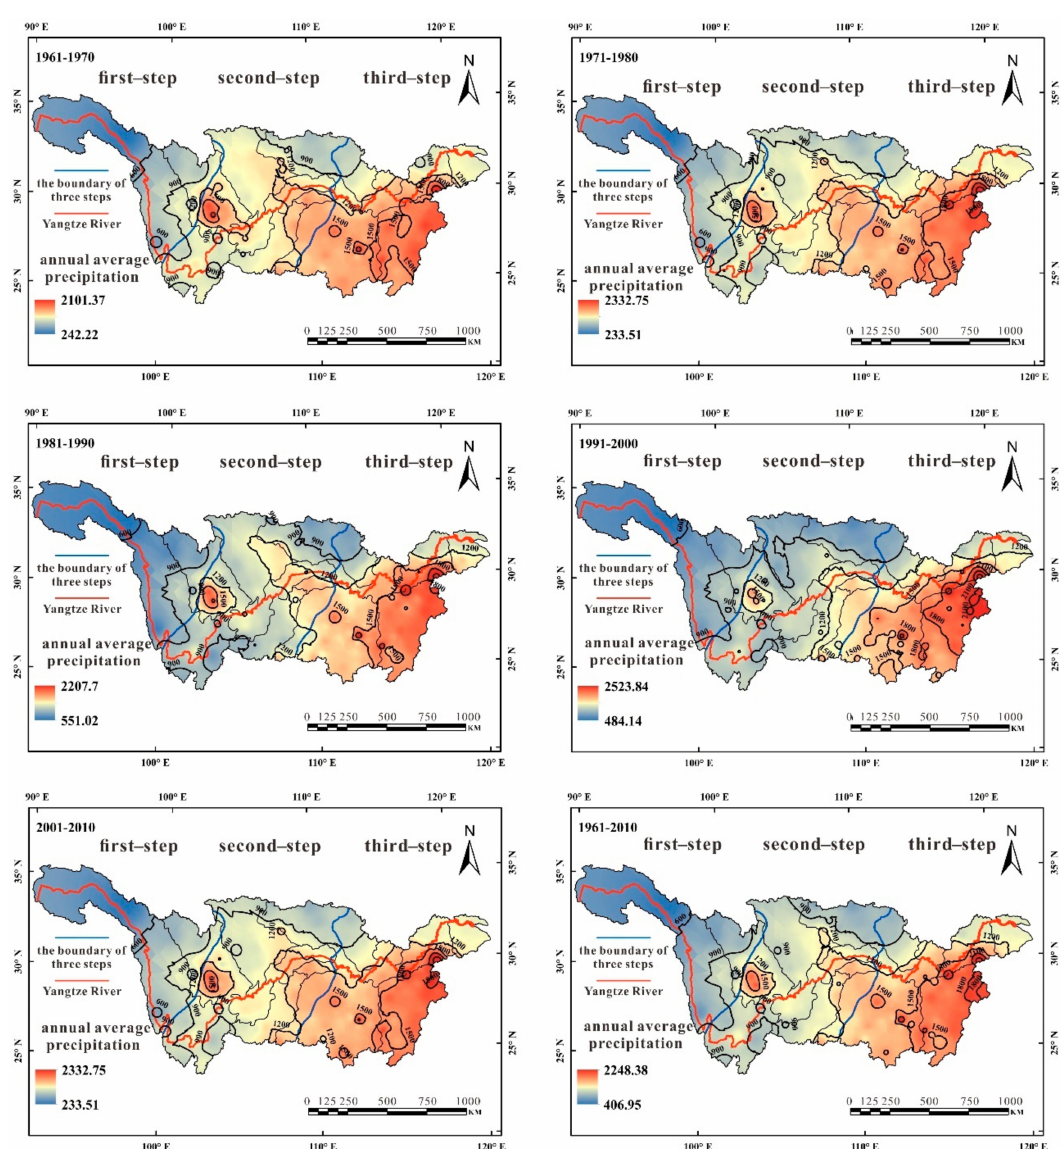
Figure 6. Spatial distribution of annual rainfall in the YRB from 1961 to 2010. By using the Mann–Kendall trend test, we observed that the annual rainfall in the YRB presented an “increase–decrease–increase” trend from east to west (Figure 7). Our results show that the annual rainfall increased in the first and the third topographic steps; the areas with increasing annual rainfall included the Yunnan–Guizhou Plateau in the southeast of the Qinghai–Tibet Plateau and the west of the Nanyang Basin. The annual rainfall in the eastern part of the Taihu Lake Basin and the upper basin of the Jinsha River Basin showed an increasing trend (passing the 0.05 significance test). On the other hand, the areas with annual rainfall reductions were all located in the second topographic steps, which